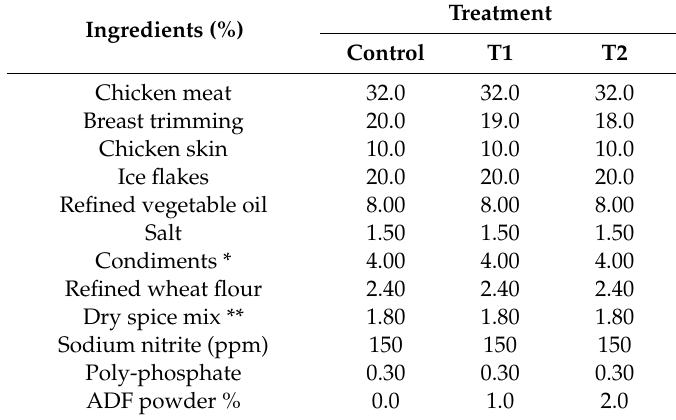
Table 1. Formulation of chicken nuggets with di ff erent levels of Moringa flower (MF) as antioxidant dietary fibre. Treatment Ingredients (%) Control T1 T2 Chicken meat